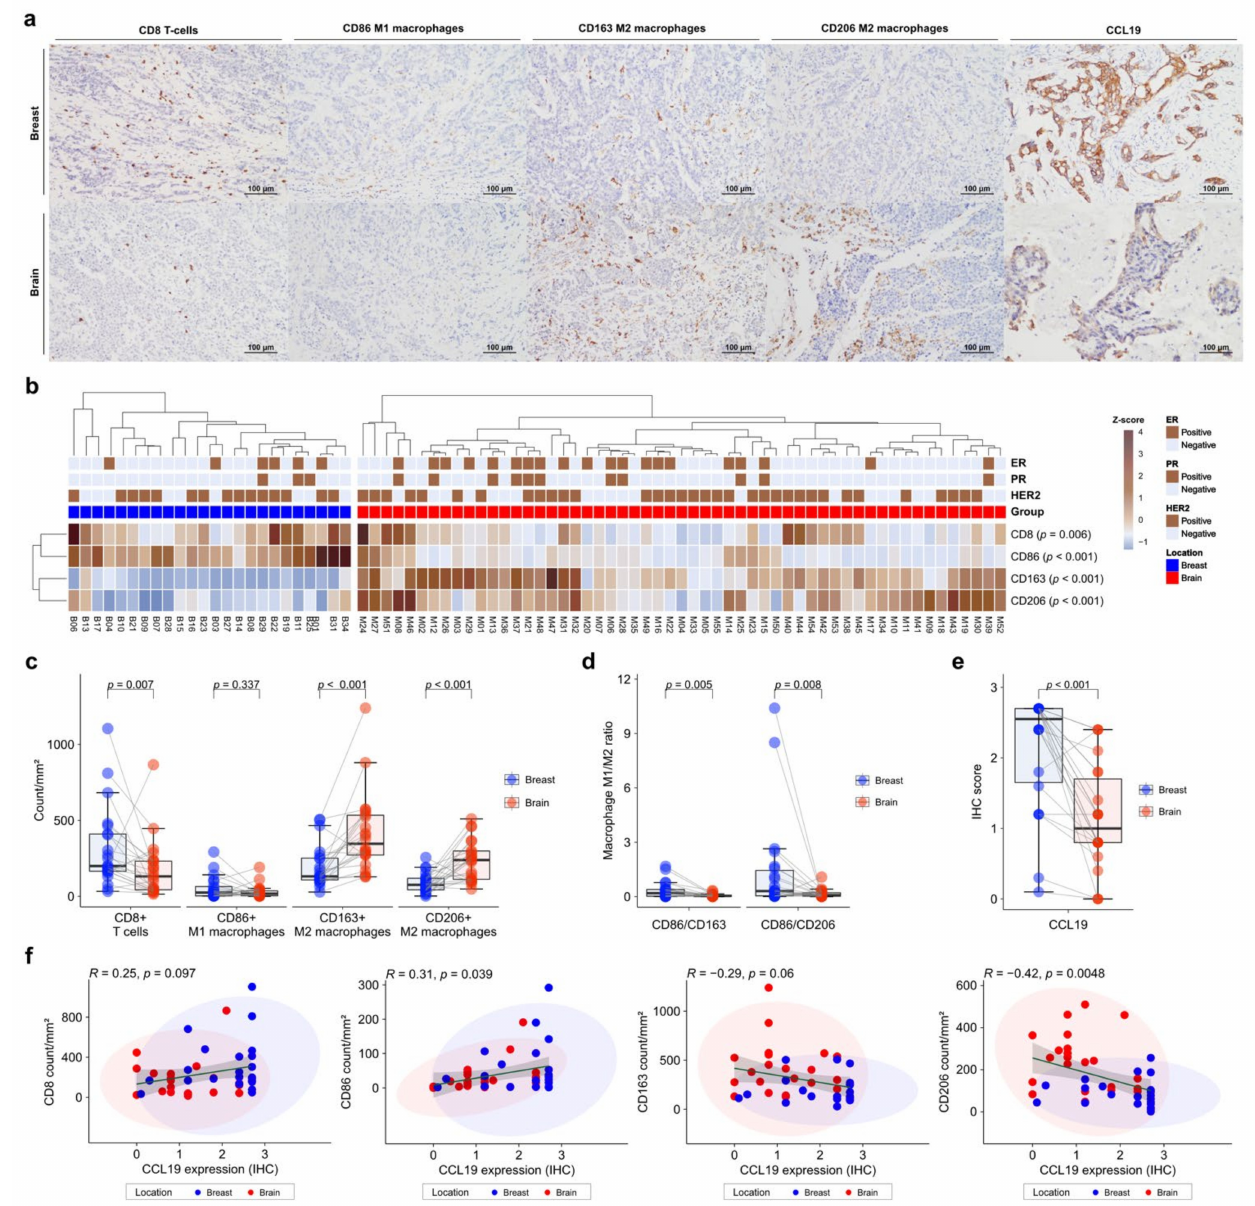
Figure 4. Immunohistochemistry (IHC) analysis of immune-cell profiles in primary breast cancer and brain metastases (BCBM). ( a ) Representative histograms of IHC on primary BCBM. From top to bottom, primary BCBM (original magnifica- tion, × 200). From left to right, immunohistochemical staining for CD8, CD86, CD163, CD206, and CCL19. ( b ) Heatmap of the IHC count of CD8+, CD86+, CD163+, and CD206+ cells in 55 cases of BM and 24 primary breast cancers according to location. ( c ) Pairwise box plots of counts of CD8+ cells, CD86+ cells, CD163+ cells, and CD206+ cells according to tumor location. ( d ) Pairwise box plots showing the relative proportions of CD86+ cells per CD163+ cells or CD206+ cells according to tumor location. ( e ) Pairwise box plot of CCL19 expression in 24 matched pairs of primary breast cancer and BM samples according to tumor location. ( f ) Linear correlation analyses of CCL19 expression in association with CD8+, CD86+, CD163+, and CD206+ counts, visualized as dot-correlation